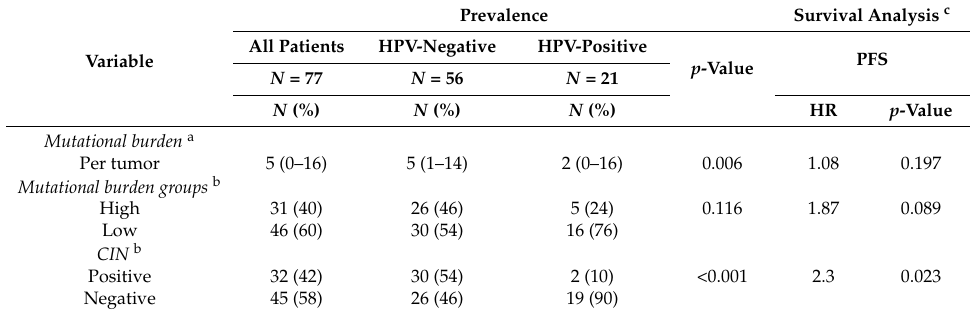
Table 3. The association of mutational burden (total number of somatic point mutations) and presence of the chromosomal instability marker (CIN) with progression free survival (PFS).